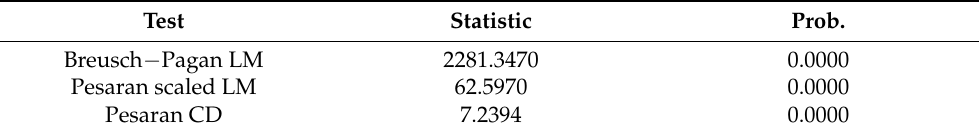
Table 3. The results of cross − sectional dependence tests.